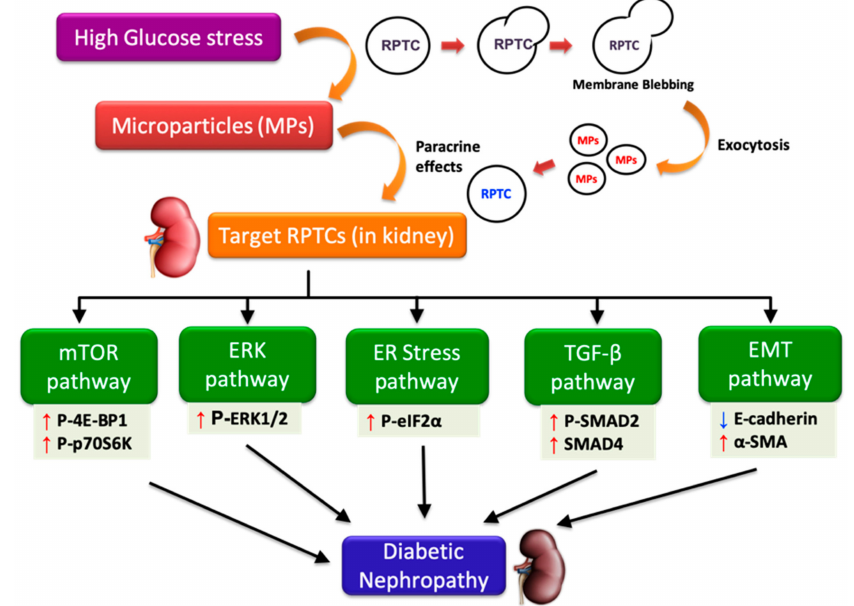
Figure 7. High glucose-derived microparticles (MPs; 10 µ g / mL) induce multiple signaling pathways such as the mammalian target of rapamycin (mTOR), extracellular-signal regulated kinase (ERK), endoplasmic reticulum (ER) stress, transforming growth factor-beta (TGF- β ), and epithelial-mesenchymal transition (EMT) in renal proximal tubular cells (RPTCs), and might potentially contribute to the development of diabetic nephropathy. Upward and downward arrows, respectively, indicate increase and decrease in protein levels. P-4E-BP1: Phosphorylated-eukaryotic translation initiation factor 4E-binding protein 1; P-p70S6K: Phosphorylated-70kD ribosomal protein S6 kinase; ERK1 / 2: Extracellular-signal regulated kinase 1 / 2; P-eIF2 α : Phosphorylated-eukaryotic initiation factor 2 α ; P-SMAD2: Phosphorylated-SMAD2; E-cadherin: Epithelial-cadherin; α -SMA: Alpha smooth muscle